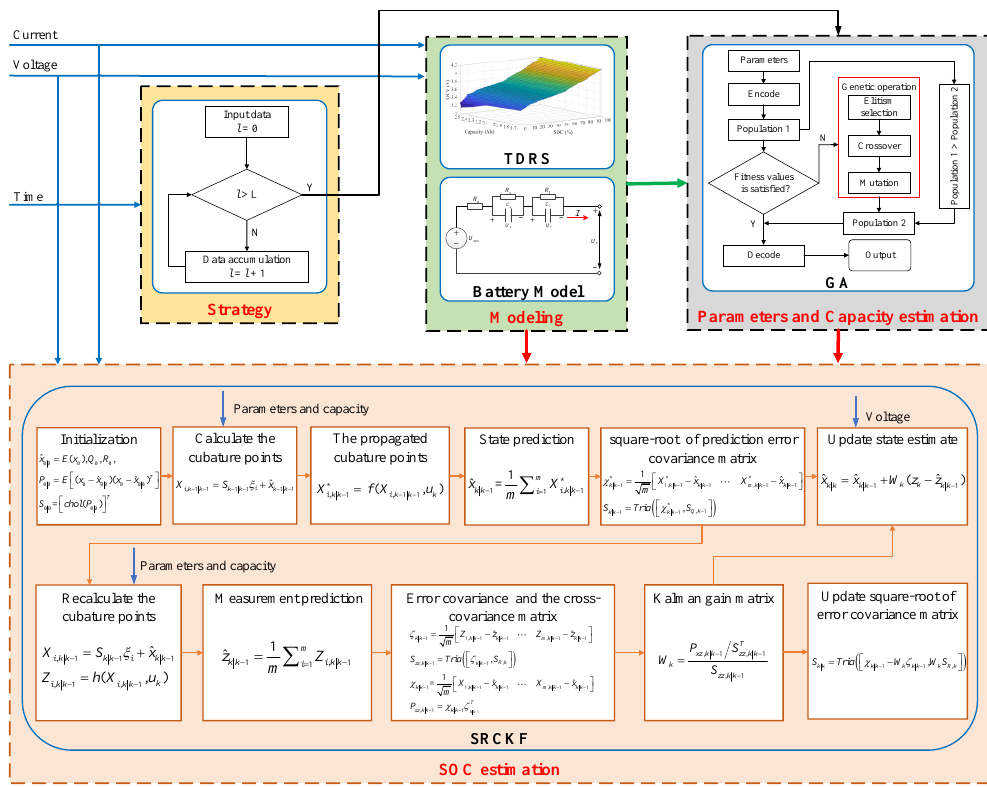
Figure 4. The scheme of the SOC and battery capacity co-estimation algorithm for lithium – ion batteries.